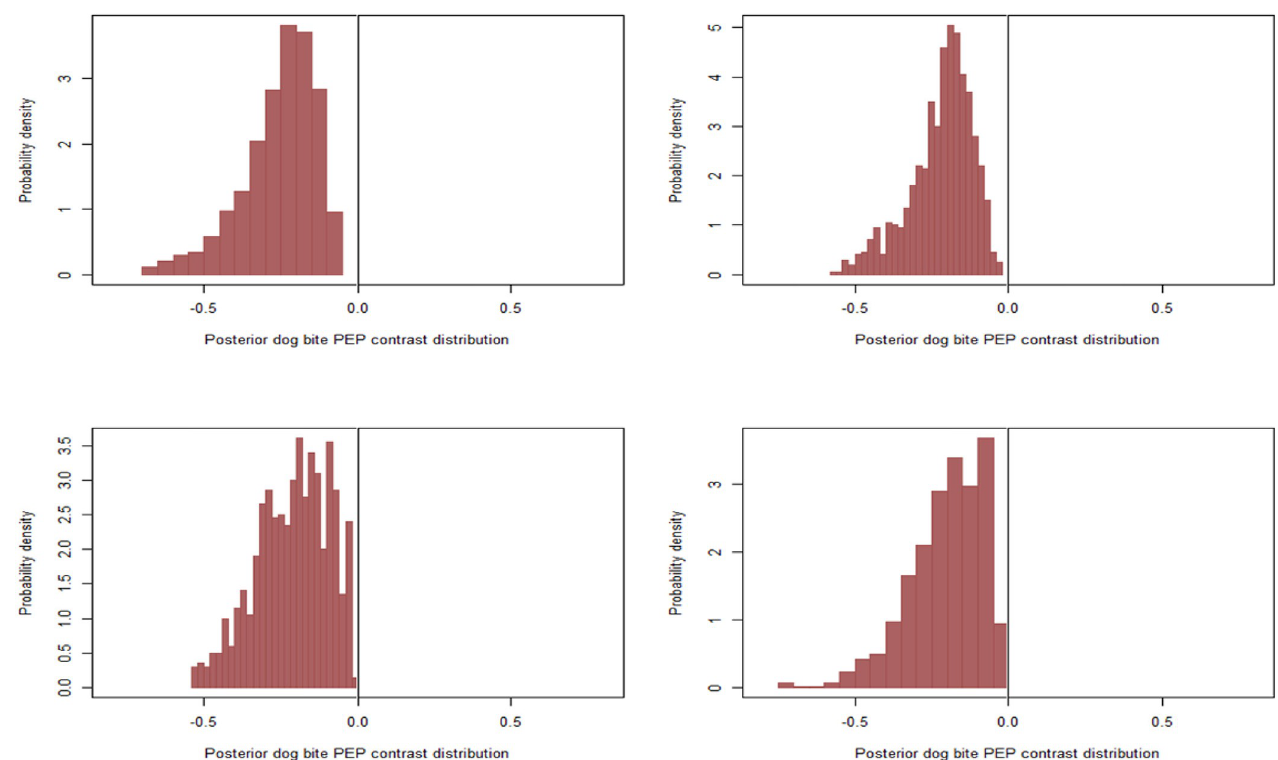
Fig 6. Posterior marginal contrast demonstrating how the estimated posterior probability of deaths was predicted to change when comparing victims who received PEP and those who did not at 35% vaccination probability to account for 3% of free-roaming dogs (Top left) when the probability of vaccination was varied between 20% and 45% in each MCMC iteration (Top right) when the probability for owned dogs was varied between 35% and 60% and 30% for free-roaming dogs (Button left) and when we varied the probabilities between 25% - 75% for owned and 20%- 45% for free-roaming dogs(button